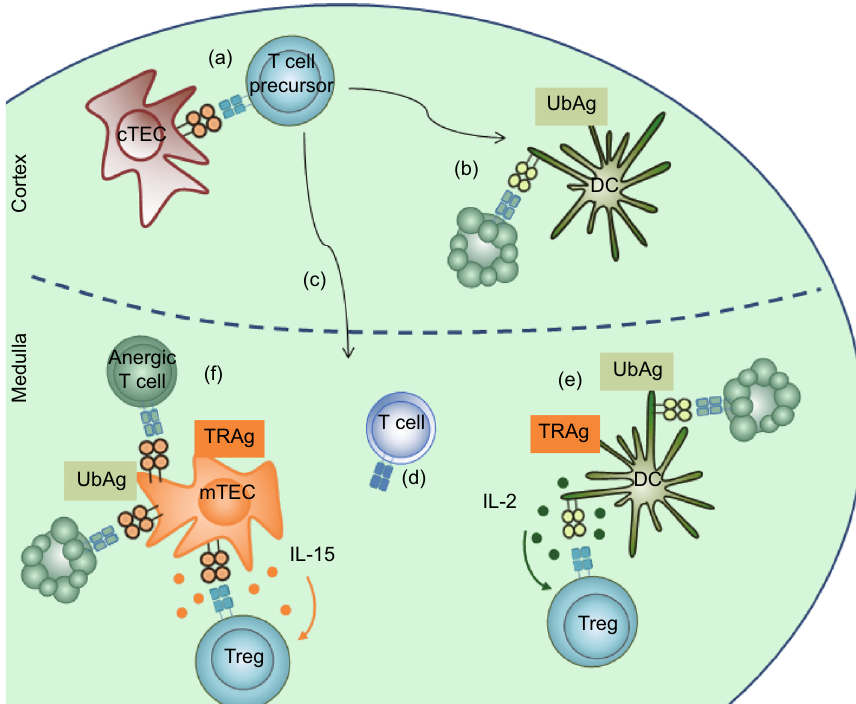
Figure 1. A model for thymic development and selection of Treg. Rescue from programmed cell-death of probably common Tconv/Treg precursors requires interaction of their TCR with MHC/peptide complexes expressed on the surface of cortical thymic epithelial cells (cTEC) (a). The thus positively selected precursor-population undergoes a fi rst wave of negative selection (i.e., induction of apoptosis) in the cortex, depleting it of cells speci fi c for the “ ubiquitous ” antigens (UbAg) presented by cortical dendritic cells (DC) (b). Surviving thymocytes upregulate CCR7 and CCR4 and migrate to the medulla (c) where precursors that recognize MHC/self-peptide complexes with low af fi nity develop into fully mature Tconv (d). T cell-precursors that recognize MHC/self-peptide complexes with higher af fi nity have three distinct destinies; become anergic, die by apoptosis, or differentiate into Treg. The latter processes appear to especially concern cells speci fi c for the peripheral-tissue restricted antigens (TRA) expressed by mTEC and presented by mTEC or, upon transfer, by thymic DC. The signals, that determine which of the three distinct outcomes a given autospeci fi c T cell-precursor will adopt, remain incompletely identi fi ed, but the IL-2 produced by DC (e) and mTEC-derived